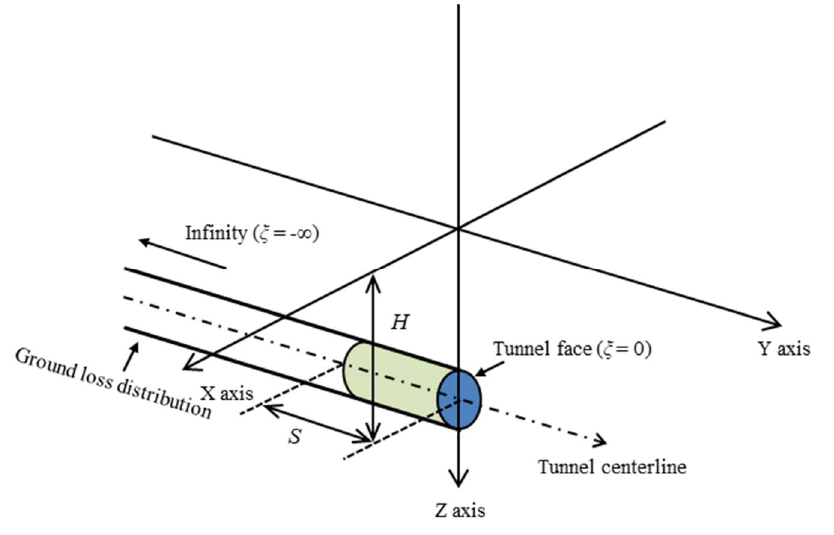
Figure 7. Ground loss distribution along the shield tunneling axis.